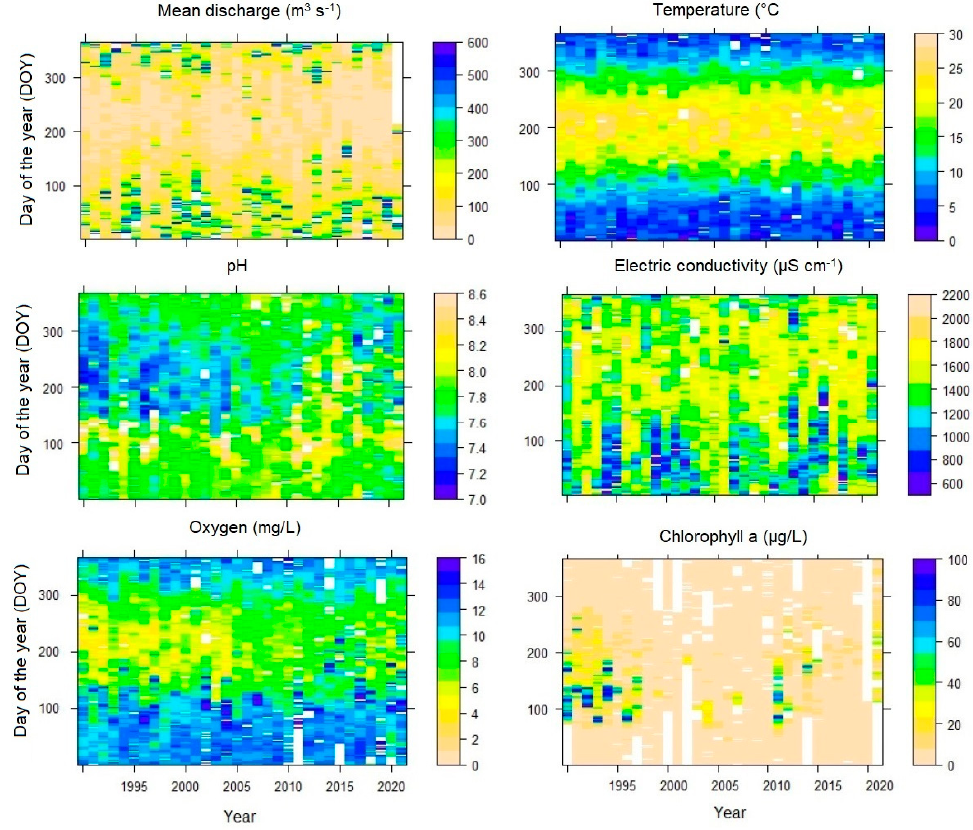
Figure 5. Changes in discharge, temperatures and the water quality parameters pH, EC, oxygen and chlorophyll a between 1990 and 2021 ( x -axis) plotted against the day of the year ( y -axis). Data represent daily averages from the stations Palzem (chemical parameters) and Perl (discharge and tem- peratures).